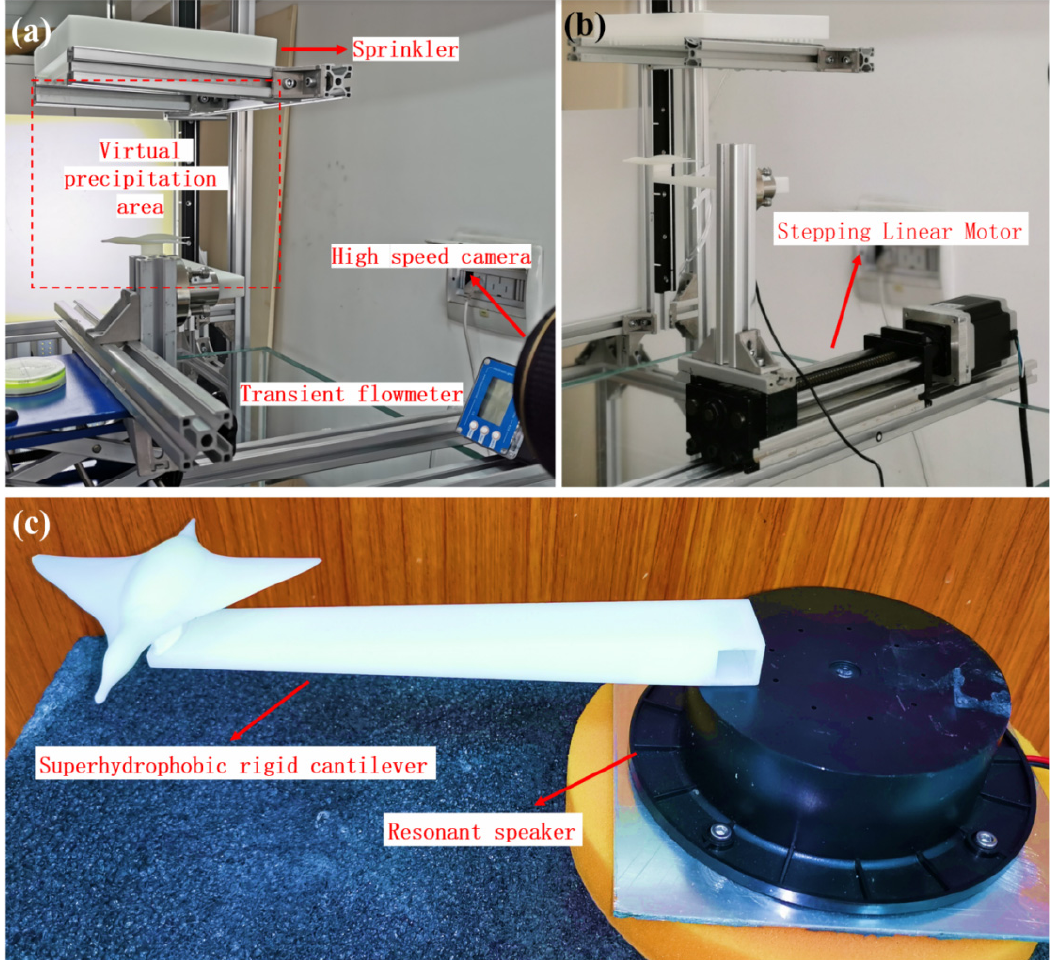
Figure 2. High-speed-camera system: ( a ) Settings for zones of simulated precipitation. The model is placed in a simulated-precipitation area, and the instantaneous flowmeter controls the size of the droplets to be consistent; the droplets fall vertically and hit the model. ( b ) Configuration of stepper motors. The model, cantilever beam, and linear stepping motor are connected; the model moving speed is 0.3 m/s. ( c ) Attachment of cantilever for resonant-speaker testing. The computer controls the vibration, driving selected frequencies through the power amplifier to the resonant speaker (see “S1. Devices and Analysis” and “S2. Vibration Control” in the Supplementary Material).